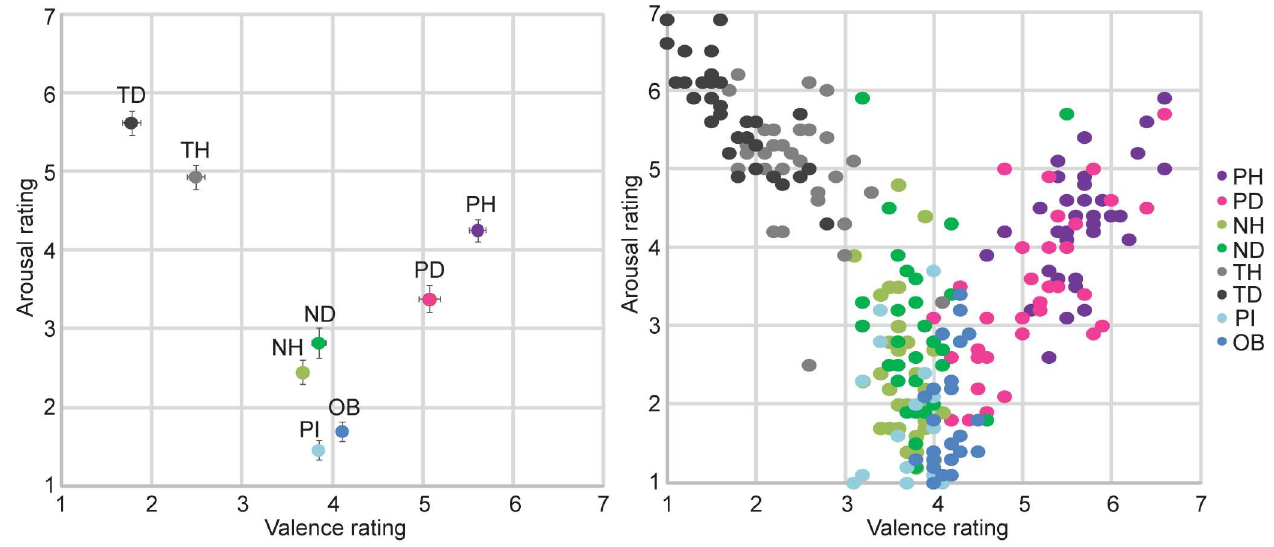
Fig 1. Valence and arousal ratings. Positioning of the subject ratings of human, dog, object and pixel stimuli on the classical valence(x-axis; 1 = negative, 7 = positive)and arousal (y-axis; 1 = low arousal, 7 = high arousal)dimensions. Left: Subject grand mean ratings with SEM, Right: Individual subject mean ratings of each category. PH = Pleasant Humans, PD = Pleasant Dogs, NH = Neutral Humans, ND = NeutralDogs, TH = Threatening Humans, TD = ThreateningDogs, PI = Pixels, OB = Objects.